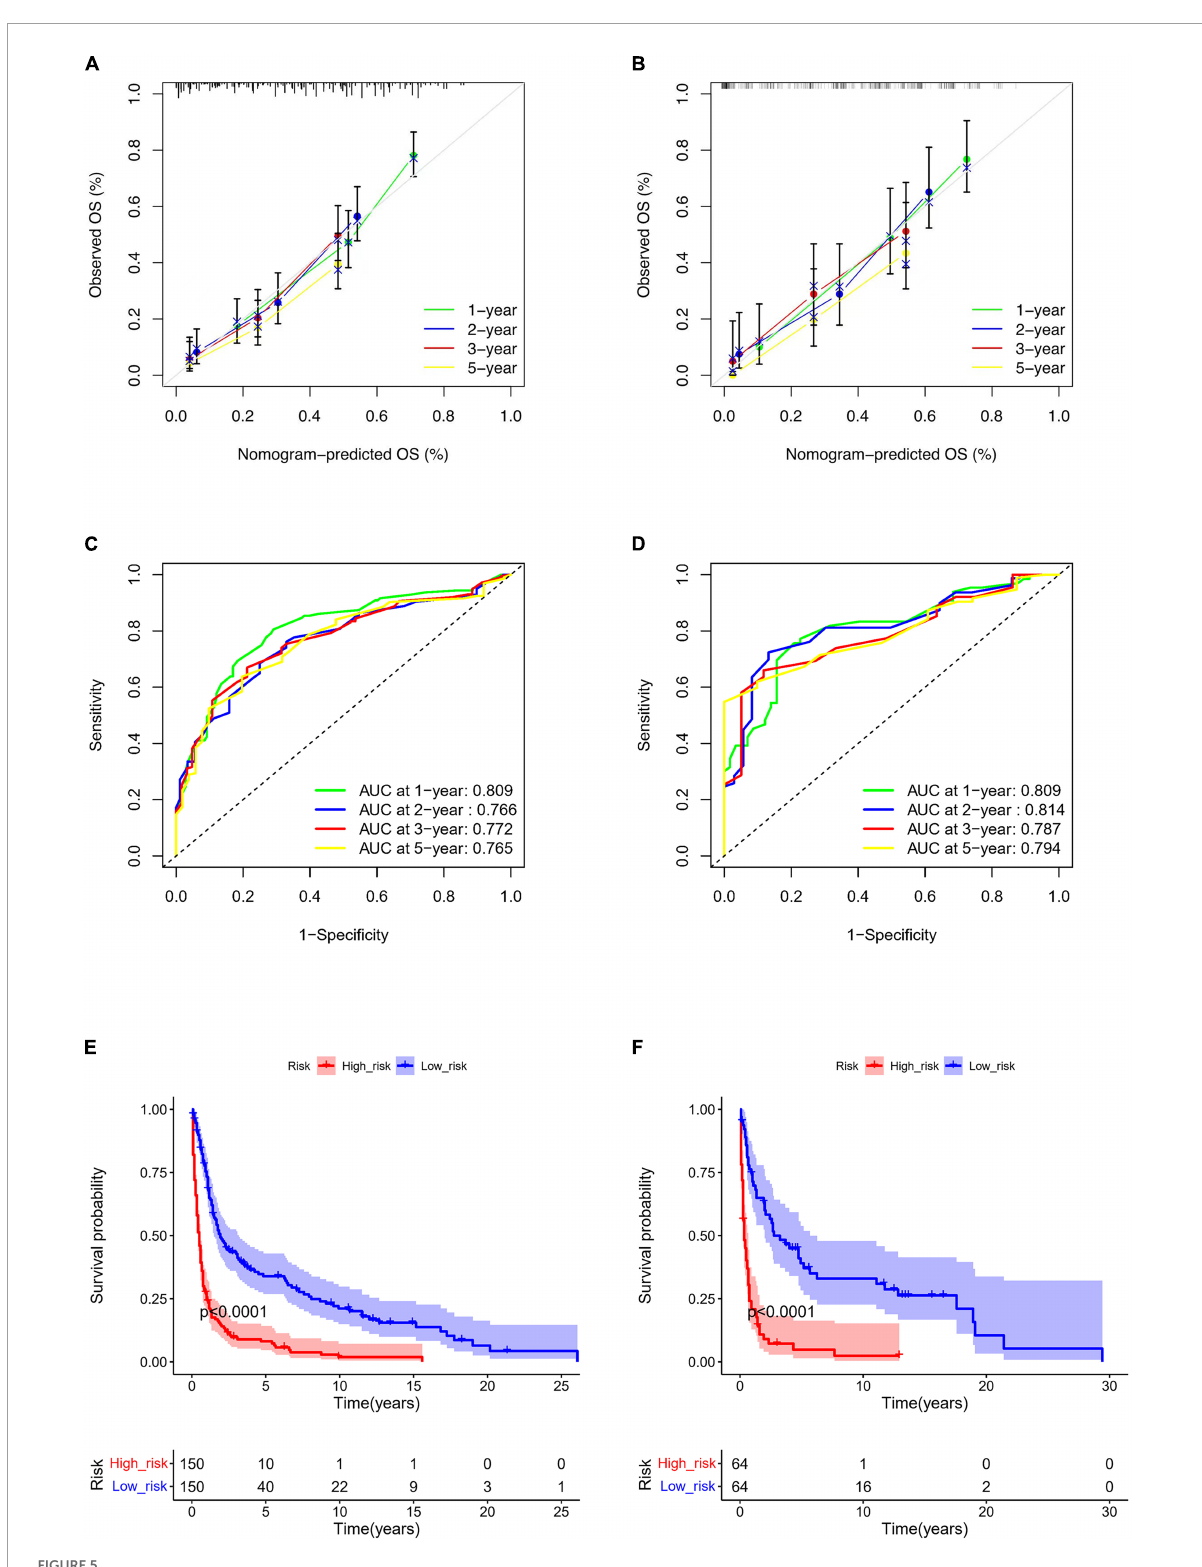
FIGURE5 Nomogram calibration curves for predicting OS in the training (A) and the validation set (B) . ROC curves of the nomogram in the training (C) and the validation set (D) . Kaplan-Meier curve of the low- and high-risk groups in PCS patients according to the risk scores in the training (E) and the validation set (F)